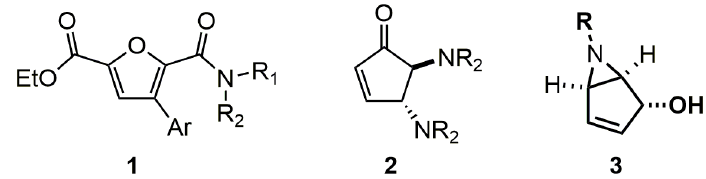
Figure 1. Examples of target synthetic building blocks.